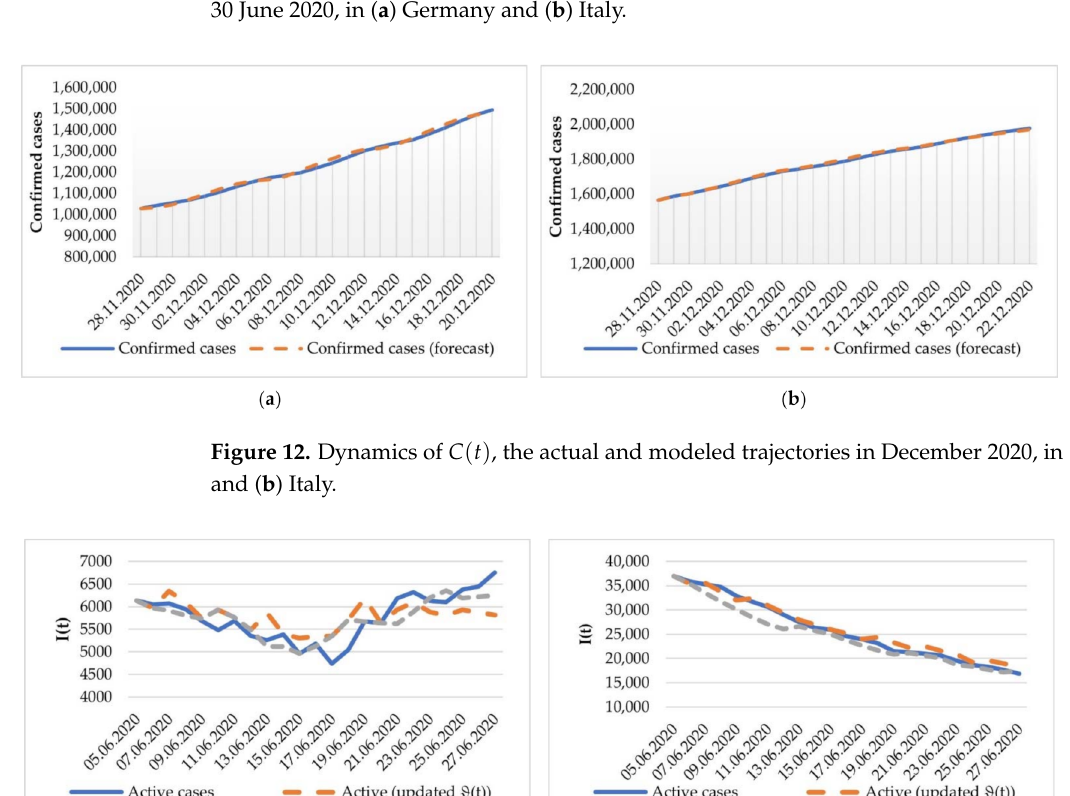
Figure 11. Dynamics of C ( t ) , the actual and modeled trajectories in the interval, from 6 June to